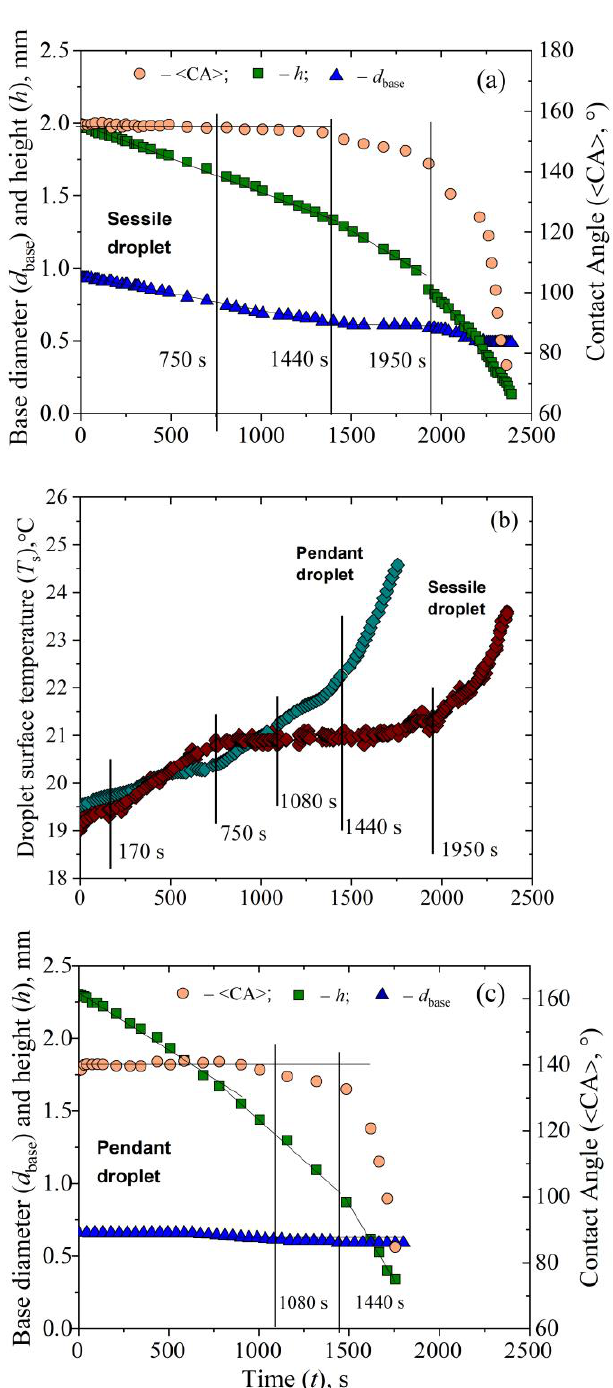
Figure 5. Change in the base diameter, height, and contact angle for sessile ( a ) and pendant ( c ) droplets. ( b ) Comparison of the surface temperature dynamics for sessile and suspended